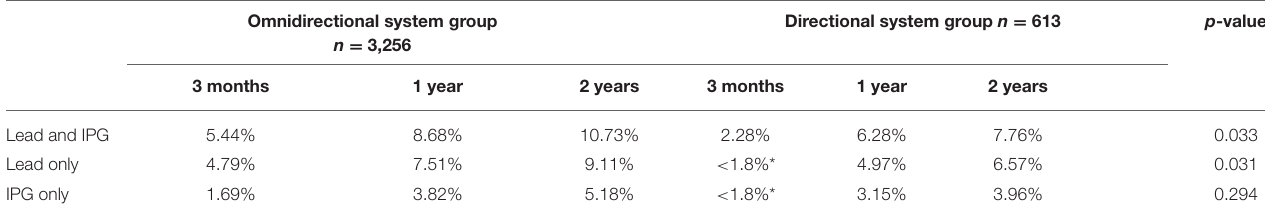
TABLE 4 | Rate of patients experiencing complications at selected time points, based on unadjusted Kaplan–Meier analysis ( * indicates suppression of cells with fewer than 11 counts, per Centers for Medicare and Medicaid Services